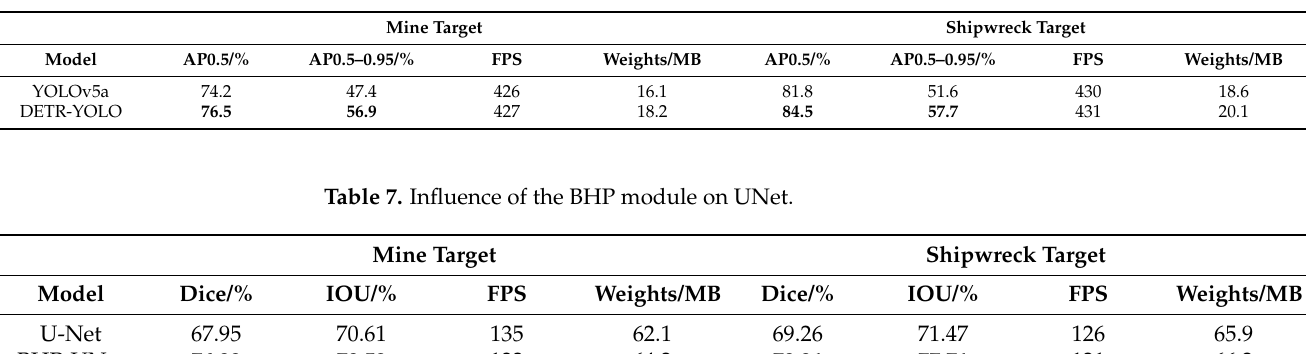
Table 6. Influence of the DETR module on YOLOv5.